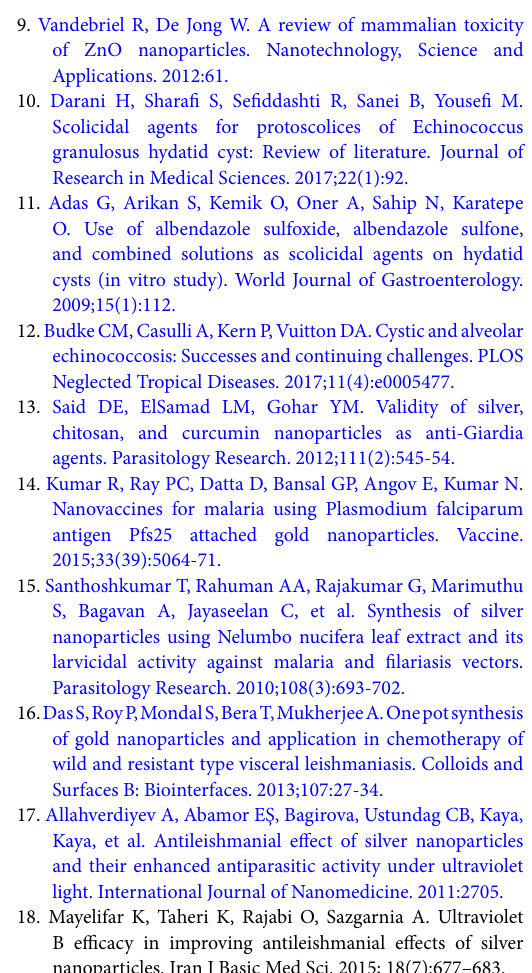
Fig. 4. Scolicidal effects of different doses of nano ZnO after various exposure Fig.4. Scolicidal effects of different doses of nano ZnO after various exposure times